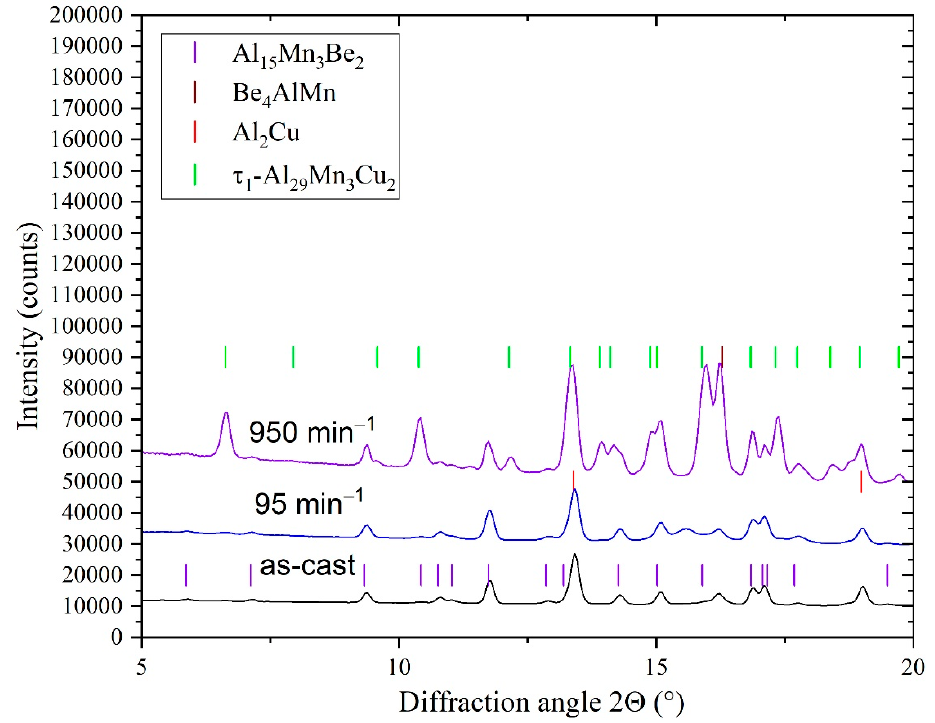
Figure 6. X-ray spectra of the investigated alloy in the as-cast condition and after friction stir pro- cessing (taken close to area A in Figure 2).